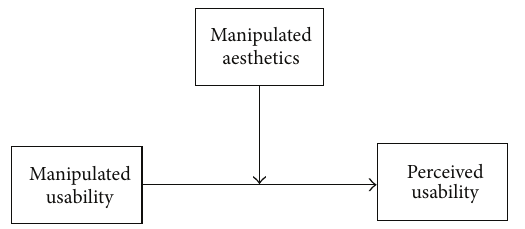
Figure 2: Moderating effect of manipulated aesthetics on the effect of manipulated usability on perceived usability.